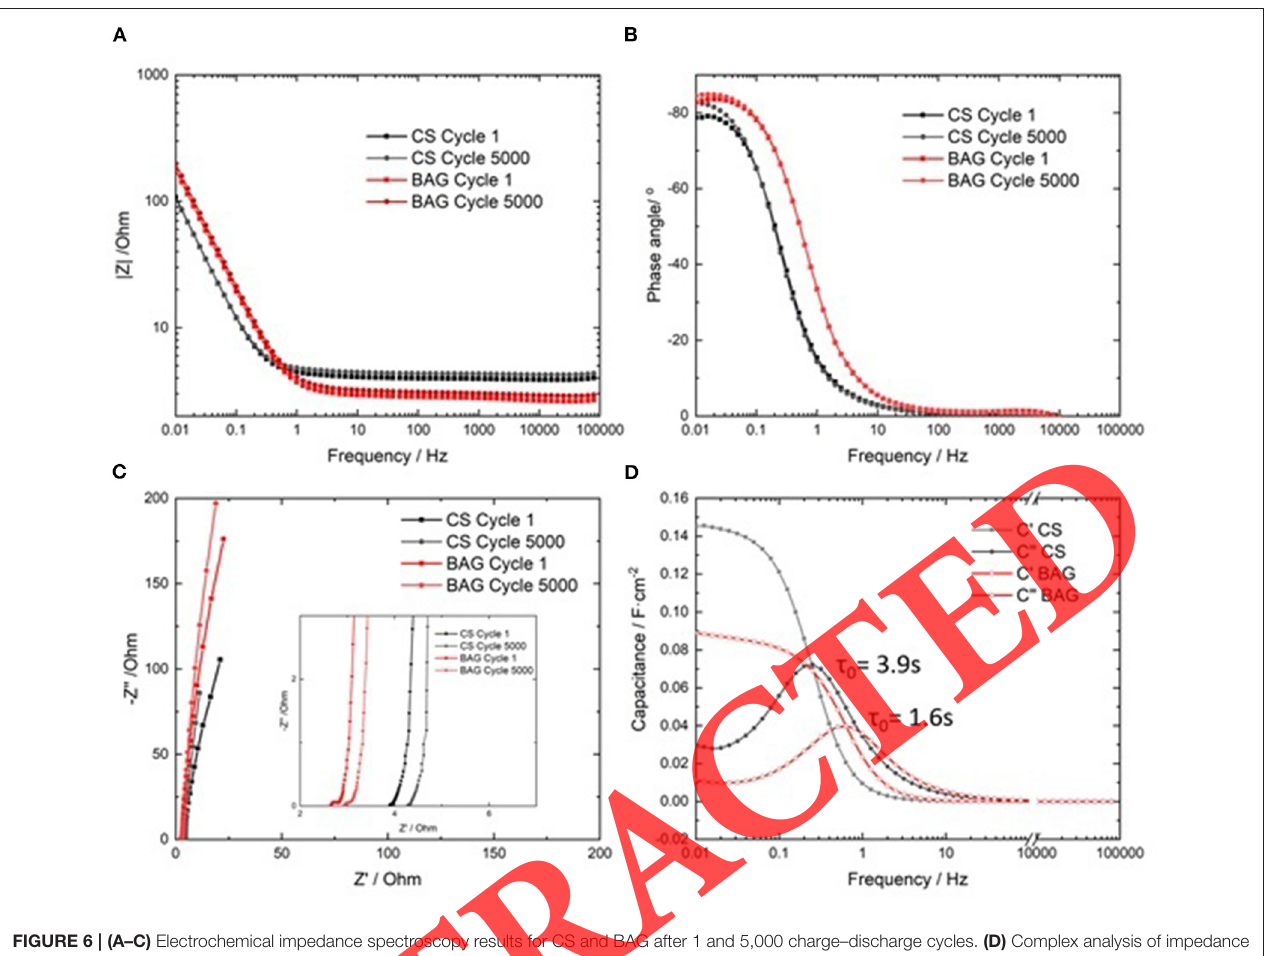
FIGURE 6 | (A–C) Electrochemical impedance spectroscopy results for CS and BAG after 1 and 5,000 charge–discharge cycles. (D) Complex analysis of impedance